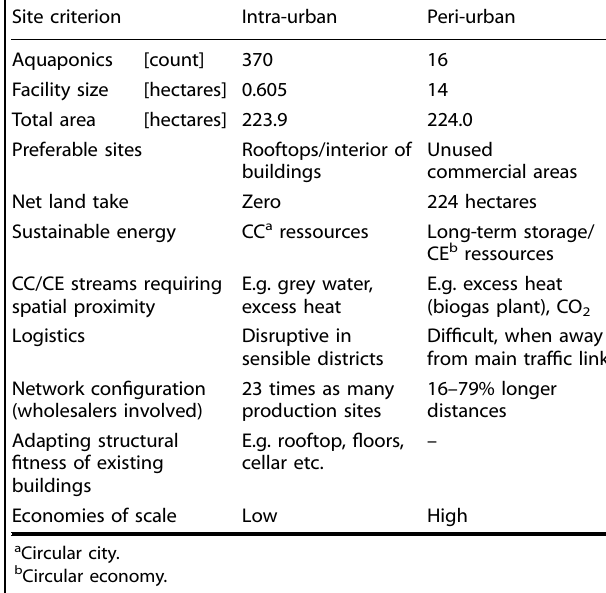
Table 3. Comparison of boundary conditions for two upscaled aquaponic scenarios, each covering Berlin ’ s demand for freshwater fi sh, lettuce and tomatoes on its own (Intra-urban quantities derived from Baganz et al. 34 ).